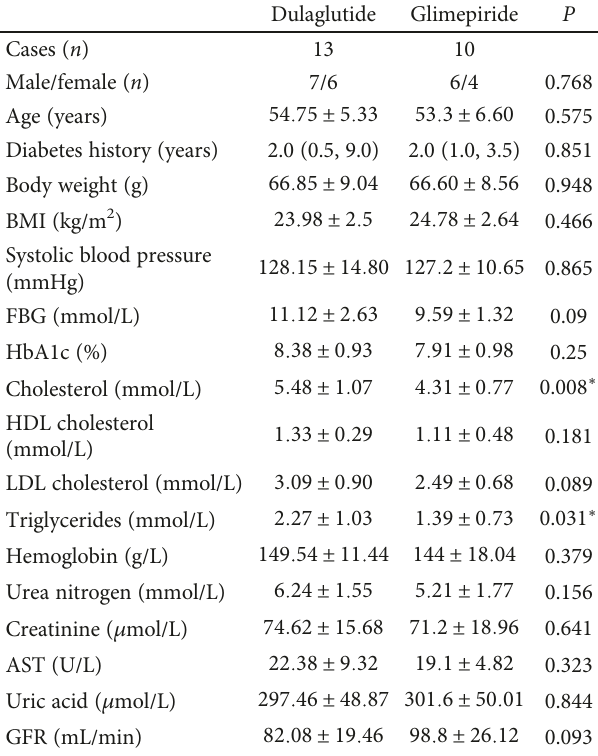
Table 1: Characteristics of